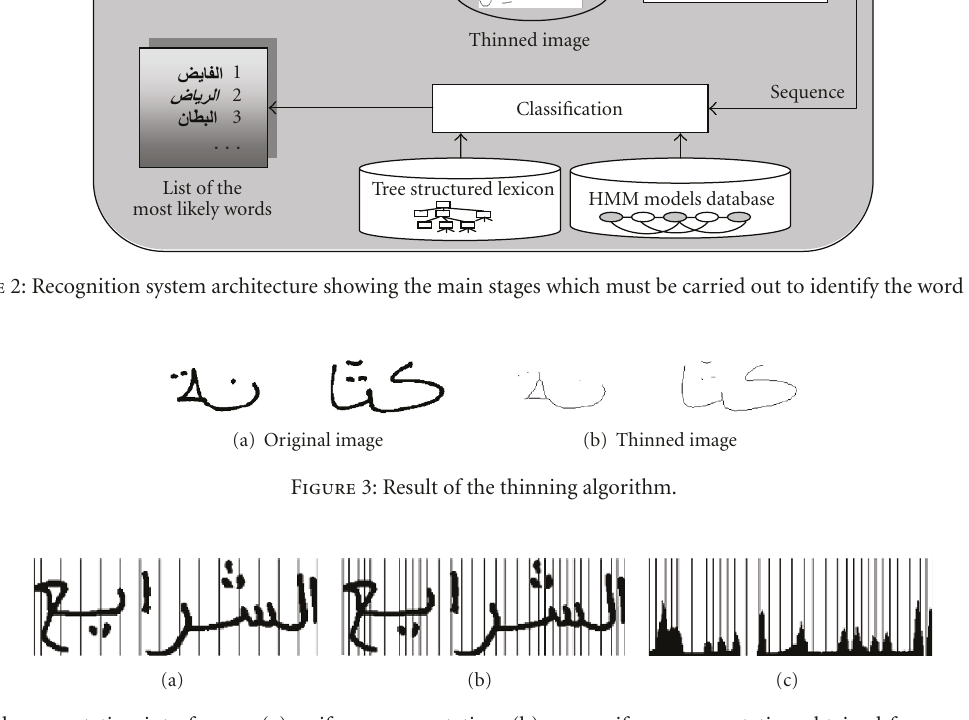
Figure 4: Word segmentation into frames: (a) uniform segmentation; (b) non-uniform segmentation obtained from vertical projection histogram